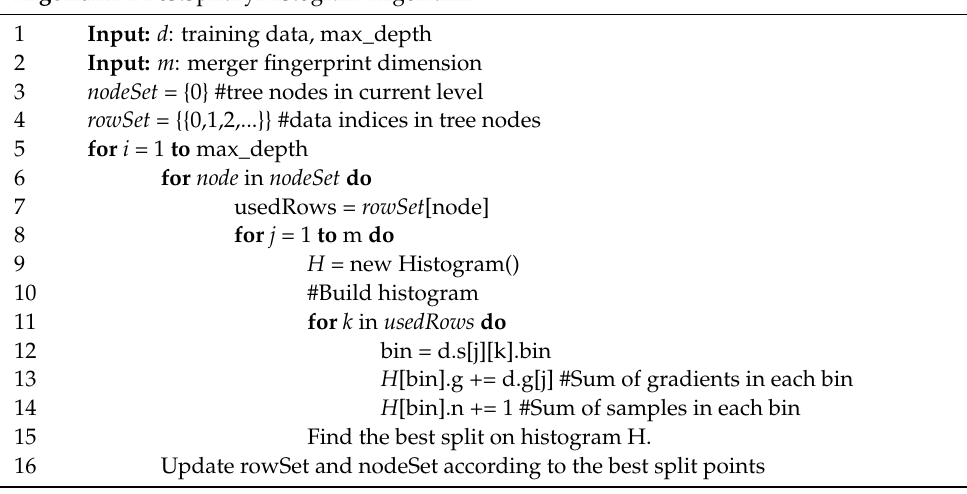
Algorithm 1 BestSplitByHistogram Algorithm